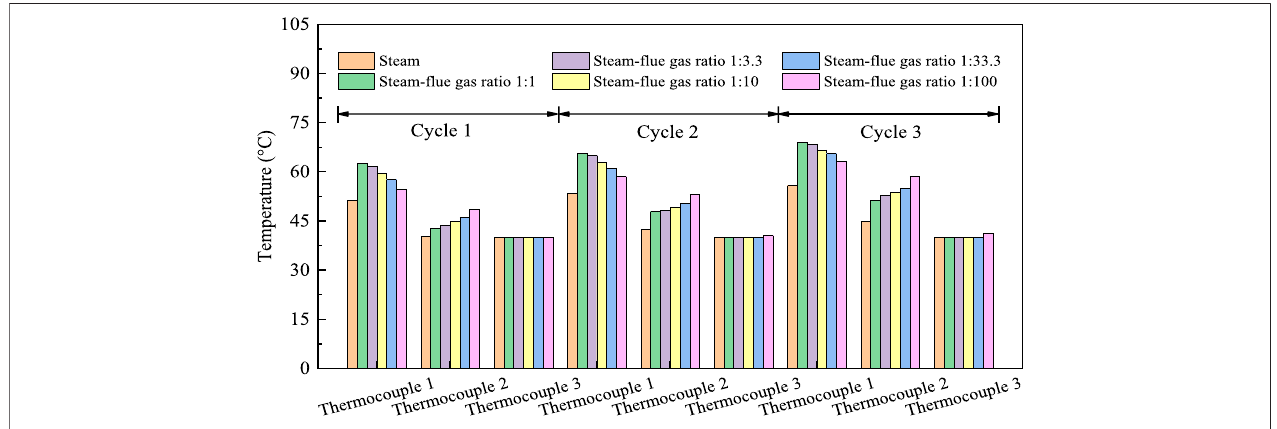
FIGURE 4 | Comparison of well-opening temperatures at different steam- fl ue gas ratios at each cycle for the three thermocouples.